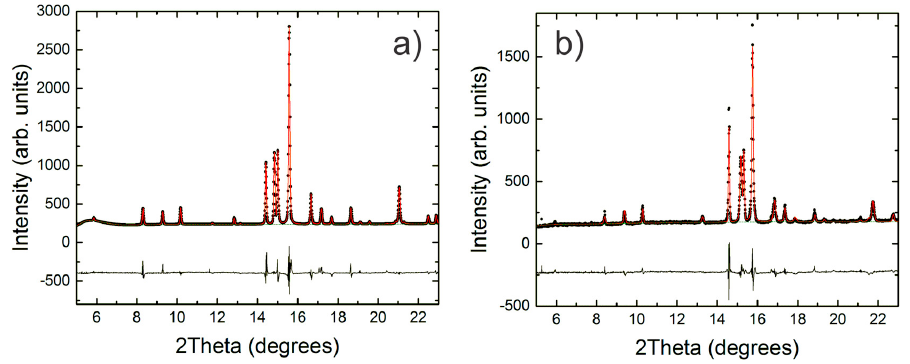
Figure 4. Rietveld refinements are shown for 0.1 GPa ( a ) and partially decompressed 3.1 GPa ( b ). The data are shown in black and the fit is shown in red. A difference curve is shown along the bottom.